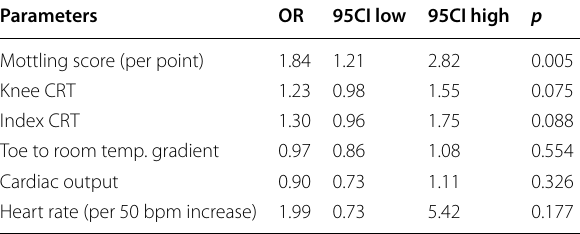
Logistic regression analysis. To avoid the risk of over-fitting and collinearity, separate models were used for each variable. The adjustment factors were defined in advance: sepsis, MAP before intubation, type of drug used at induction. The table shows the adjusted